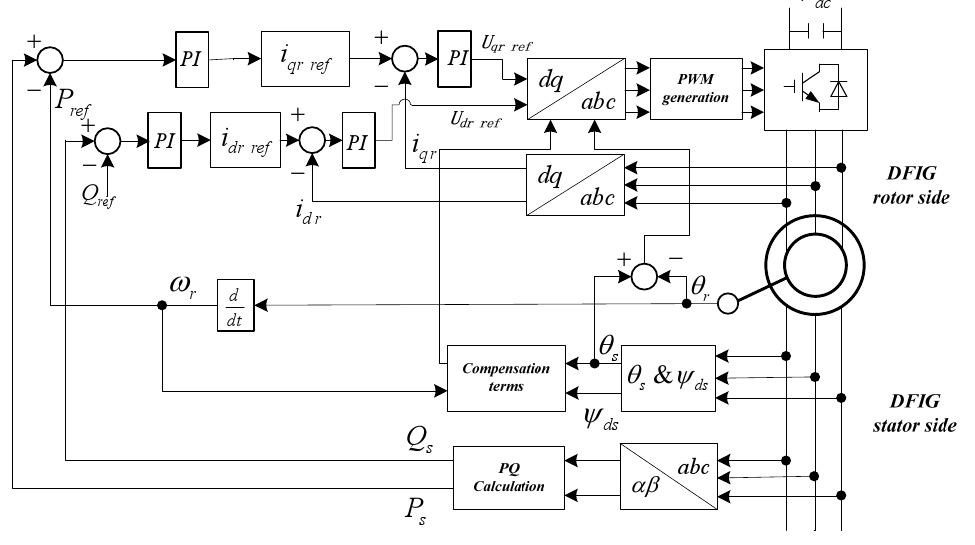
Figure 5. RSI-based stator flux vector control